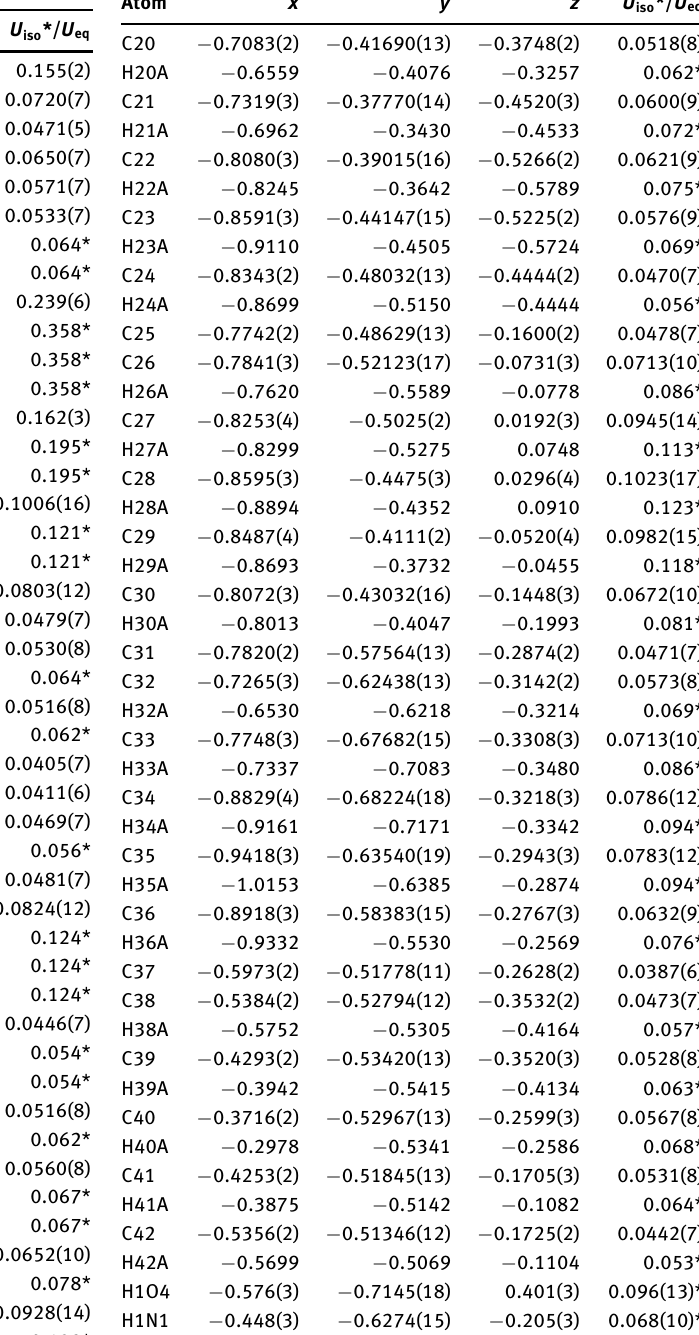
Table 2: Fractional atomic coordinates and isotropic or equivalent isotropic displacement parameters (Å 2